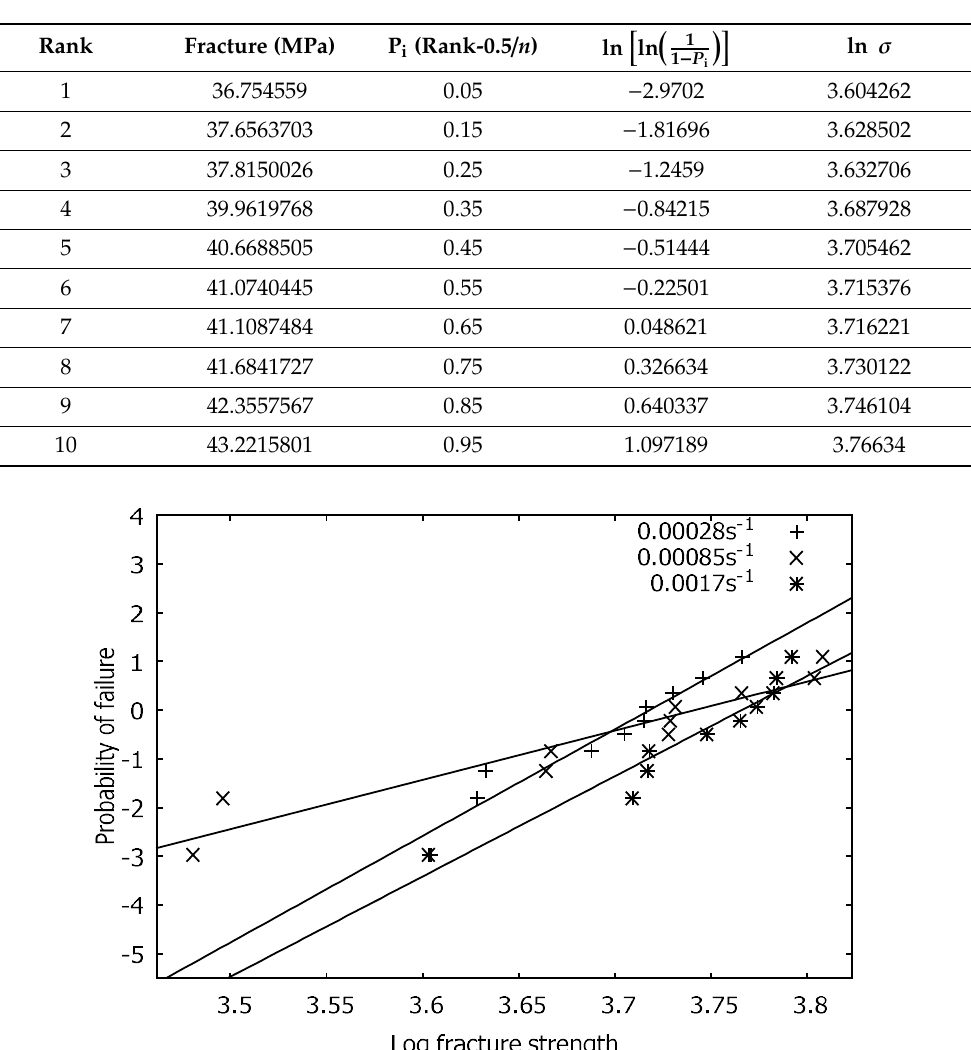
Figure 5. Weibull probability plot of 300 µ m bagasse particle-reinforced composites at di ff erent strain rates.